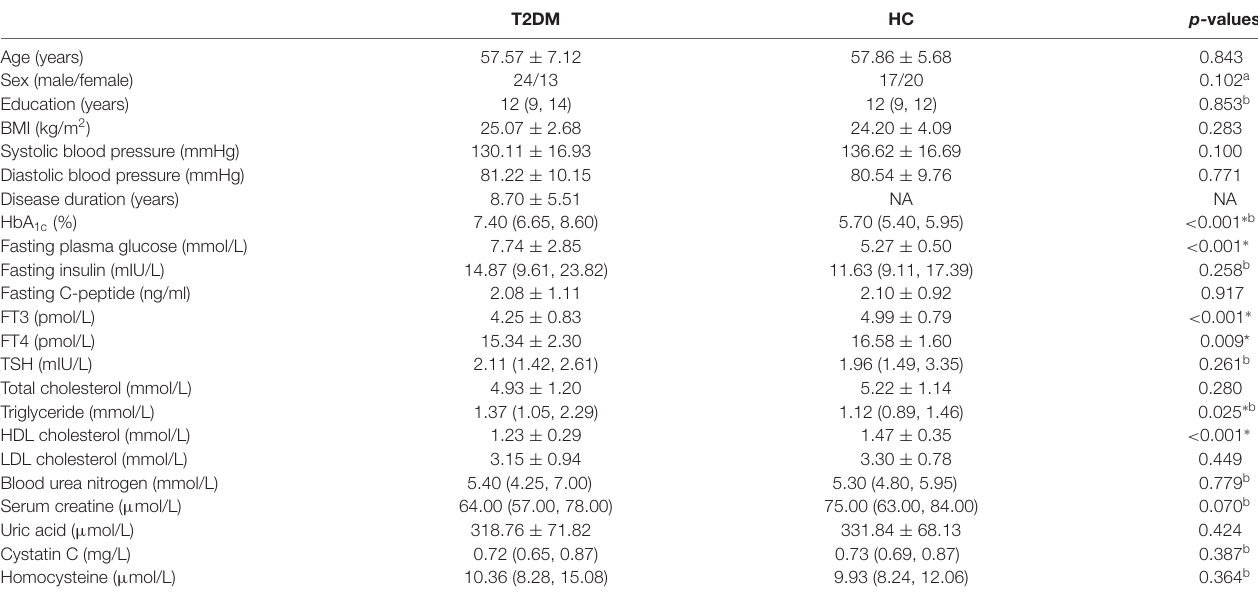
TABLE 1 | Demographic and clinical data